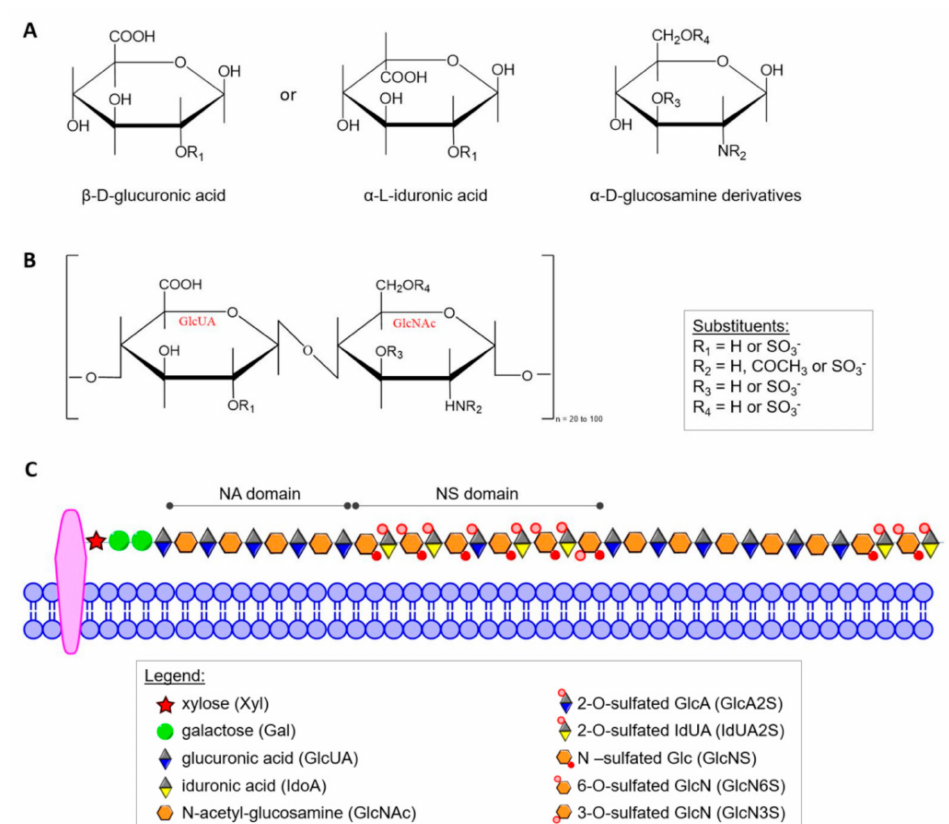
Figure 1. ( A ) Haworth projection of the heparin/HS monosaccharide units; ( B ) repeating GlcUA- GlcNAc disaccharide units of HS; ( C ) scheme of structural organization of the residues in HS. In the mature form of HS, two main types of domains can be distinguished: NA domains build mostly by non-modified N-acetyl-glucosamine moiety linked mainly to glucuronic acid residues, and NS domains that are composed by highly sulfated disaccharides